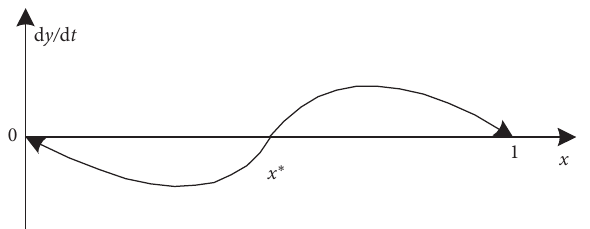
Figure 1: Changing trends of information sharing in evolutionary game x ∗ � (( C + θ